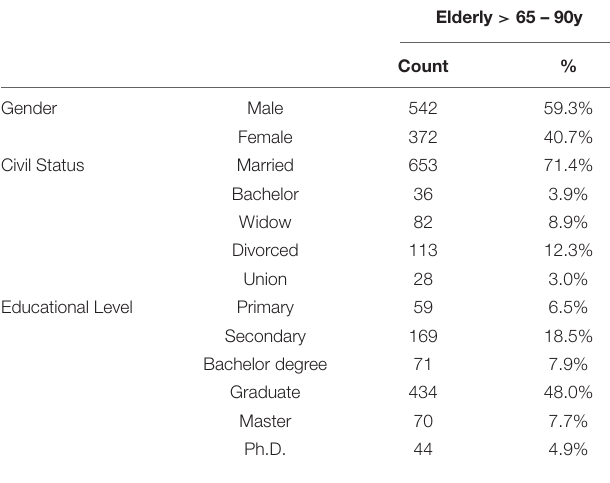
TABLE 1 | Demographic characteristics in the